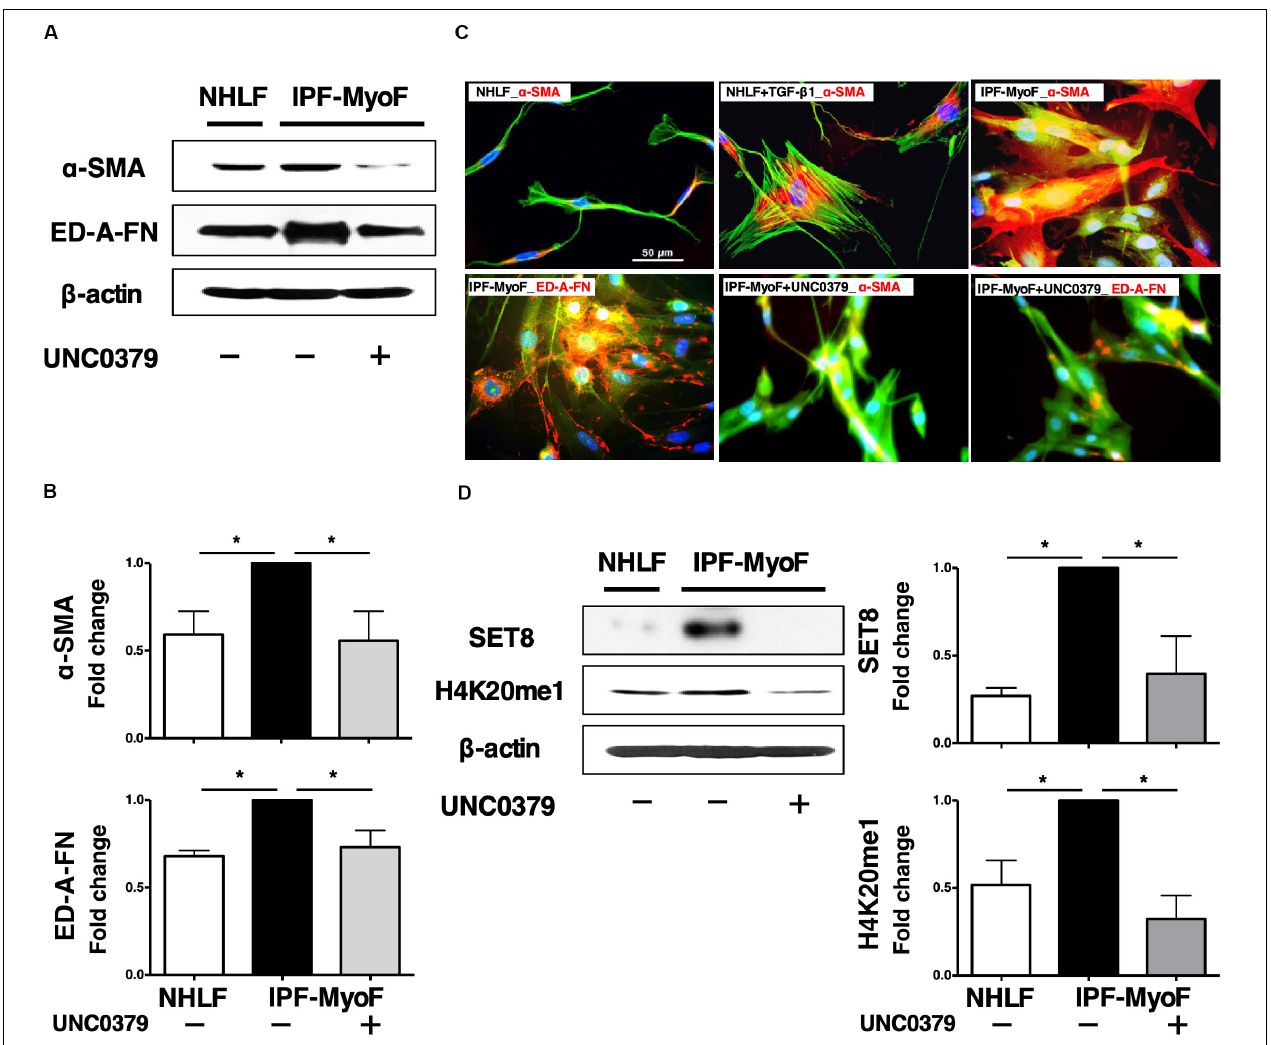
FIGURE 1 | UNC0379 reversed the phenotype of IPF-MyoF to NHLF. (A) IPF-MyoF and NHLF were treated with vehicle (PBS) or 10 µ M UNC0379 for 48 h. The expression of α -SMA, ED-A-FN, and β -actin (internal control for normalization) in the cell lysates were analyzed by WB. (B) Relative quantification data of the levels of α -SMA and ED-A-FN are expressed as fold changes with respect to the control value of IPF-MyoF with the vehicle. (C) Representative immunofluorescence staining images of α -SMA and ED-A-FN (red) in IPF-MyoF treated with or without UNC0379 and NHLF treated with or without 10 ng/ml TGF- β 1. The actin cytoskeleton and the nuclei were counterstained with phalloidin (green) and DAPI (blue), respectively. (D) The expression of SET8 and H4K20me1 in IPF-MyoF and NHLF treated as in (A) were analyzed by WB. All quantitative data are shown as the mean ± SEM ( n = 3). * p < 0.05 (measured by one-way ANOVA followed by Tukey’s